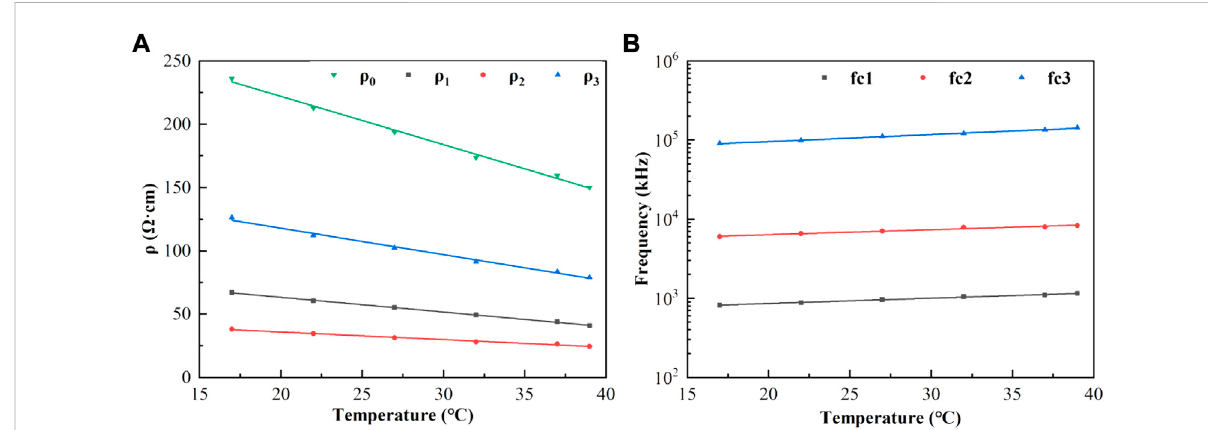
FIGURE 6 (A) : Characteristic parameters ρ 0 , ρ 1 , ρ 2 , ρ 3 (points) as a function of temperature and linear fi t (lines in corresponding colors); (B) : Characteristic frequencies f c1 , f c2 , f c3 (points) as a function of temperature and linear fi t. (lines in corresponding colors).